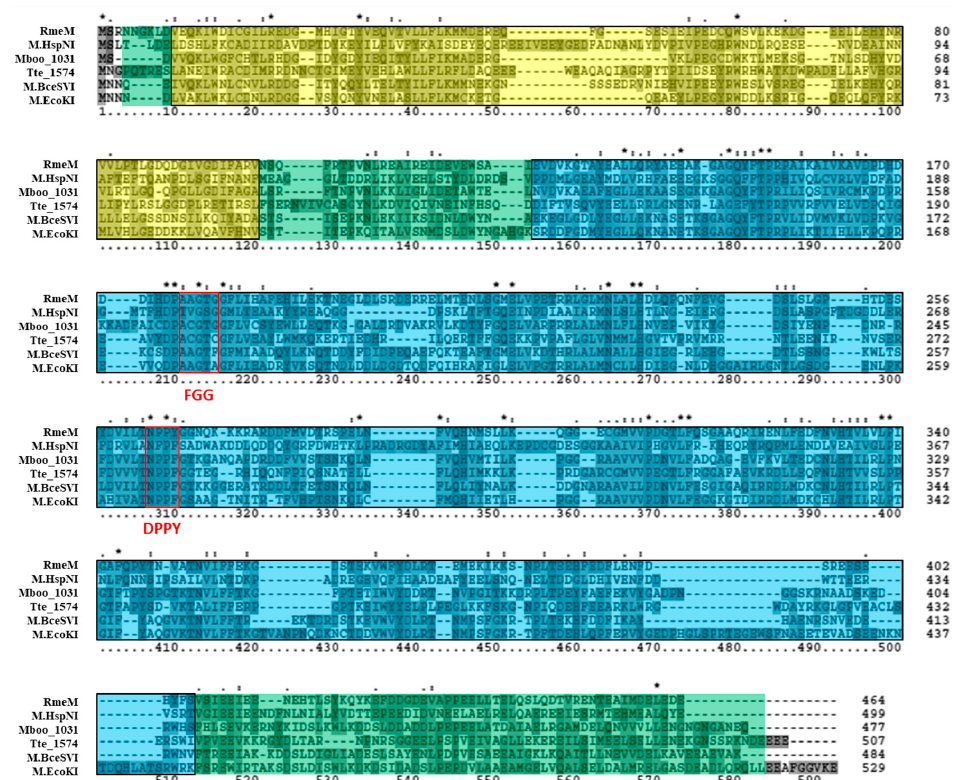
Figure 4. Amino acid alignment of RmeM homologs. The multiple sequence alignment includes RmeM ( Haloferax volcanii DS2; GenBank ADE02452), M.HspNI ( Halobacterium salinarum NRC-1; GenBank AAG18733), Mboo_1031 ( Methanoregula boonei 6A8; GenBank ABS55549), Tte_1547 ( Caldanaerobacter subterraneus subsp. tengcongensis MB4; AAM24756), M.BceSVI ( Bacillus cereus ATCC 10987; GenBank AAS39772), and M.EcoKI ( Escherichia coli K-12; GenBank P08957). The PFAM N6 adenine-specific DNA methyltransferase N-terminal domain PF12161 is highlighted in yellow, and the PFAM DNA methylase, adenine specific domain PF02384 is highlighted in blue. Red boxes are used to identify the signature DPPY and FGG motifs. The SCOP superfamily domain S -adenosyl- L -methionine-dependent methyltransferase domain SSF53335 is highlighted in green throughout the alignment. Clustal X2 shading and marking of amino acids is included in the